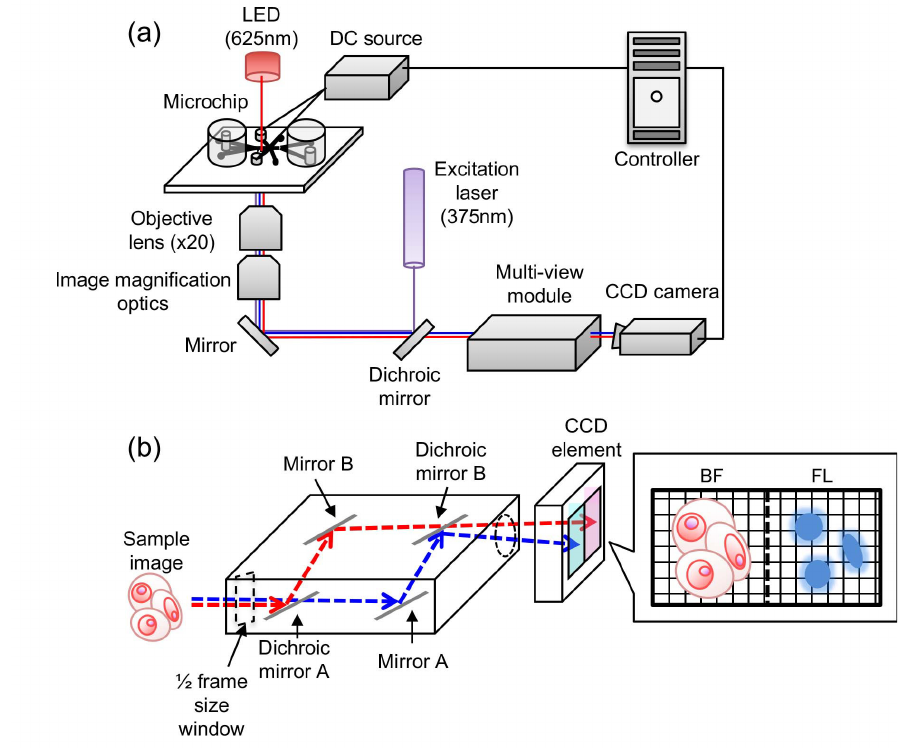
Figure 1. Set-up of the on-chip multi-imaging cell sorter system. ( a ) summary of the on-chip multi-imaging flow cytometry system. The system was composed of eight major modules: (i) microfluidic chip, (ii) bright-field (BF) light source, (iii) fluorescent (FL) light source, (iv) objective lens with image magnification optics for depth of field extension, (v) multi-view unit, (vi) high-speed charge-coupled device (CCD) camera, (vii) sorting DC voltage source, and (viii) controller, as numbered in the figure; ( b ) schematic of the multi-view